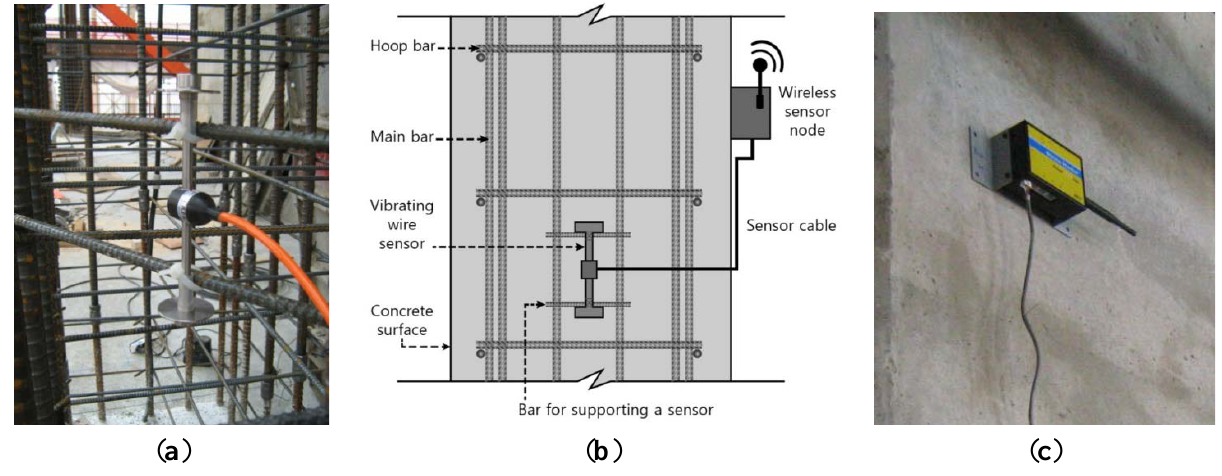
Figure 8. Installation of sensor and sensor node. ( a ) Installation of sensor; ( b ) Sensor and sensor node; ( c ) Installation of sensor